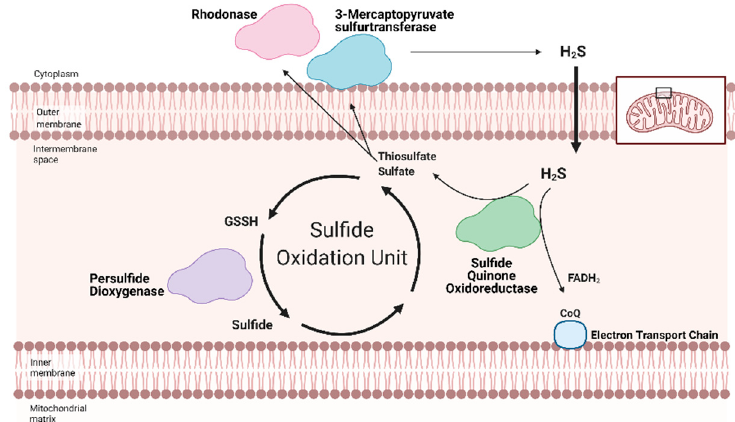
Figure 2. Hydrogen Sulfide (H2S) catabolized by the Sulfide Oxidation Unit. Free H2S can be removed from the cell either by storage in sulfane sulfur pools or the Sulfide Oxidation Unit. H2S catabolism is linked to mitochondrial respiration via sulfide quinone oxidoreductase (SQR). Nicotinamide adenosine dinucleotide + hydrogen (NADH) and flavin adenosine dinucleotide + 2 hydrogen (FADH 2 ) reduce Complex I and II, respectively. The electrons travel across the Electron Transport Chain, through Complex III and cytochrome c (Cyt c) to ultimately reduce oxygen in Complex IV. This flow generates a hydrogen gradient that drives adenosine triphosphate (ATP) synthase and allows for ATP generation from adenosine dinucleotide (ADP). SQR, a key part of the Sulfide Oxidation Unit, extracts electrons from H2S and reduces co-enzyme Q (CoQ), which transfers the electrons to Complex III, contributing to ATP production. As a byproduct, SQR also produces thiosulfate and sulfate—the former can be converted back into H2S by 3-mercaptopyruvate sulfurtransferase. As part of the Sulfide Oxidation Unit, thiosulfate and sulfate react with glutathione to form glutathione persulfide (GSSH), which is then converted into sulfide and recycled back into thiosulfate. Adapted from “Electron Transport Chain”, by BioRender.com (accessed on 24 February 2021). Retrieved from https://app.biorender.com/biorender-templates (accessed on 24 February 2021).